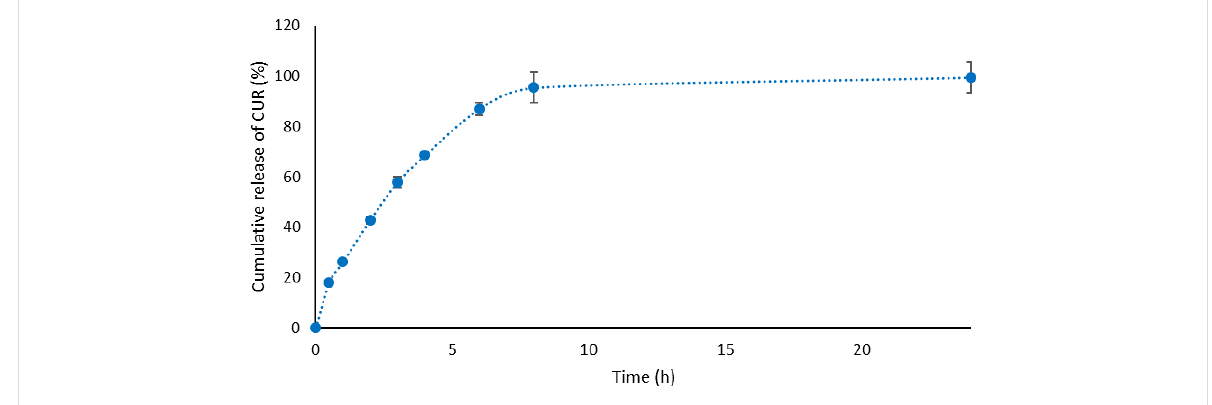
Figure 10: Release profile of CUR from a mucoadhesive nanostructured system containing 15% (w/w) P407, 0.25% (w/w) C974P and 0.08% (w/w)